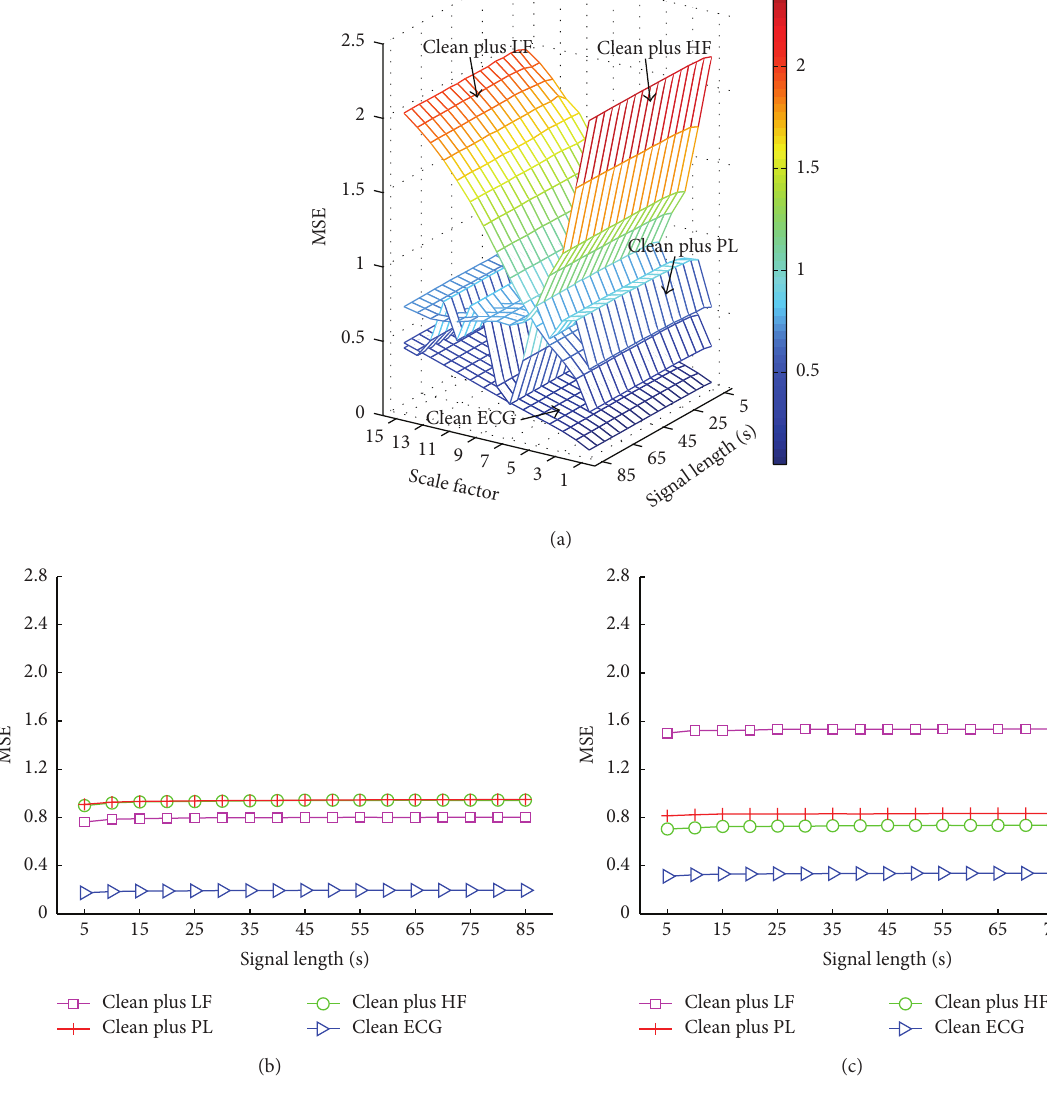
Figure 4: The effect of signal length on MSE for the artificial ECG signals. (a) The 3D view of the effect of signal length on all of the four artificial ECGs. (b) Different lengths and their corresponding MSE with a scale factor of 5. (c) Different lengths and their corresponding MSE with a scale factor of